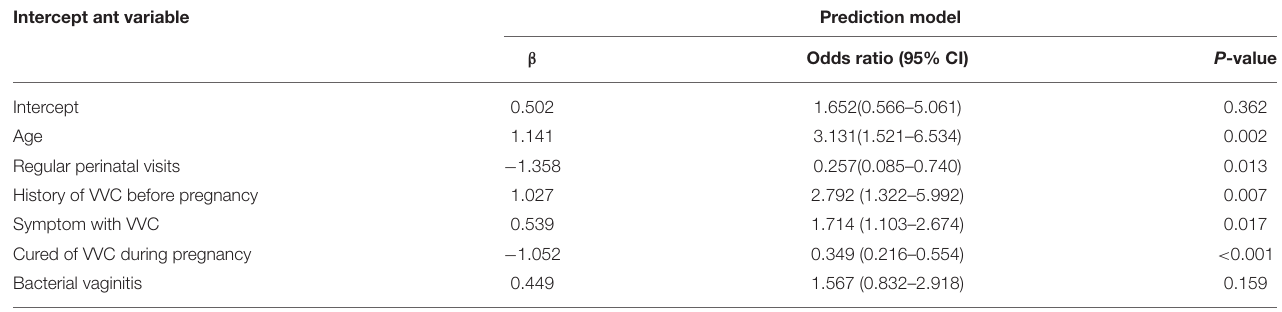
TABLE 2 | Prediction factors for PROM in pregnant patients with